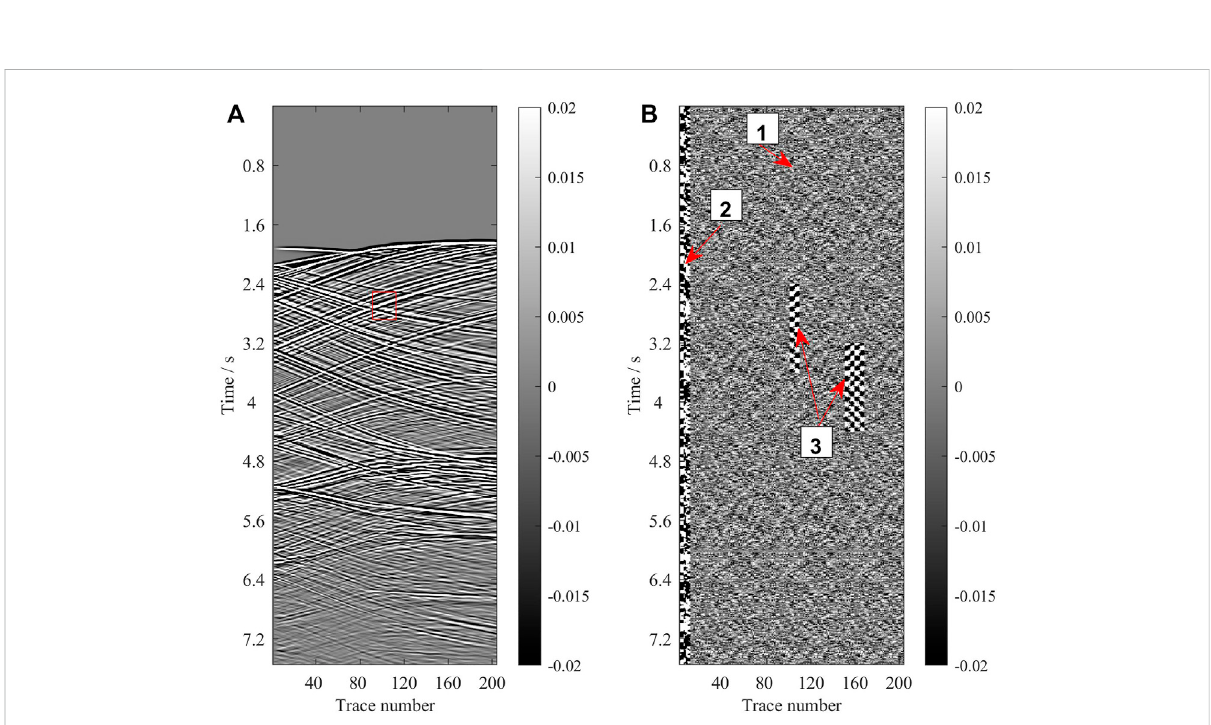
FIGURE 3 (A) Synthetic noise-free complete signal data and the shot is located at x (cid:2) 0 m. (B) Noise data from the fi eld DAS-VSP